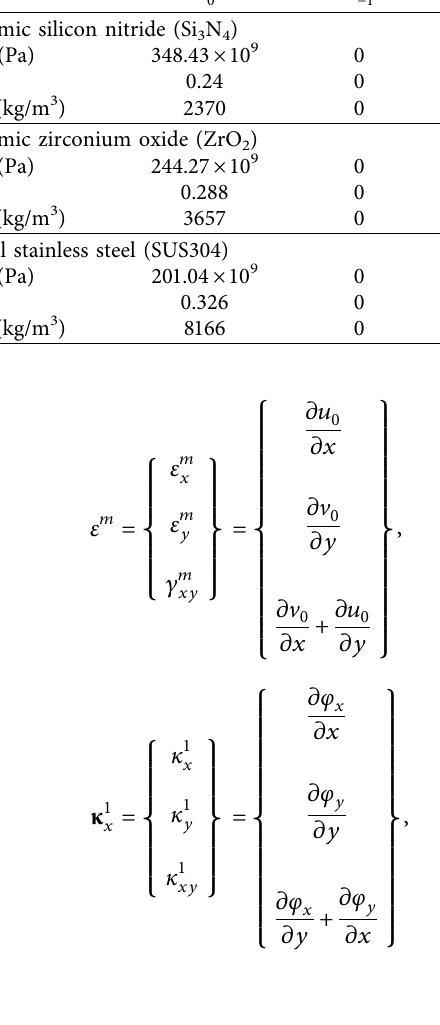
Figure 1: The model of a piezoelectric FGM plate resting on a two-parameter elastic foundation. Table 1: Temperature-dependent coefficient of Young’s modulus E (Pa) and Poisson’s ratio ] for various materials.